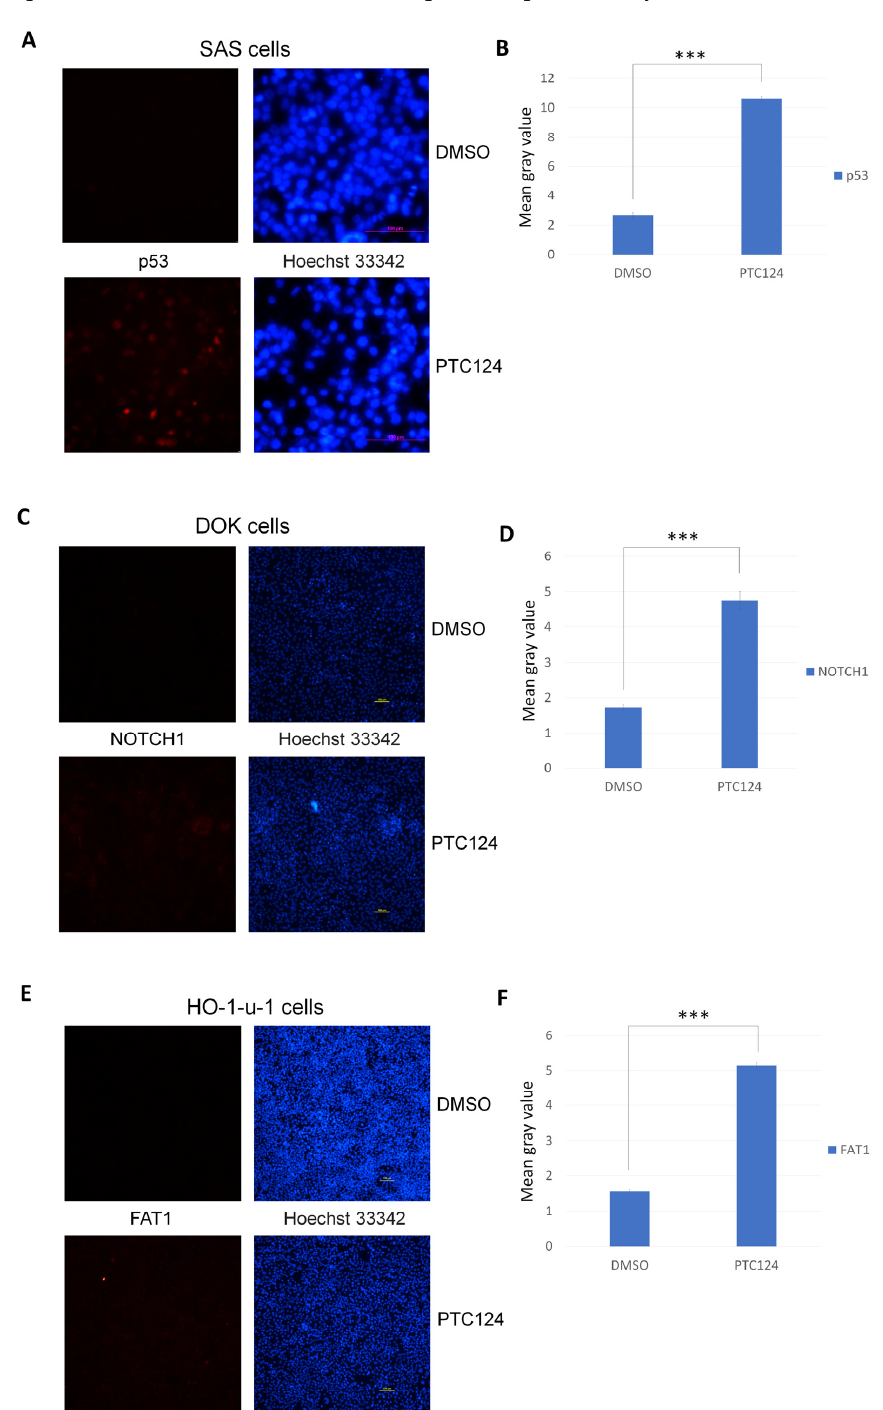
Figure 2. PTC124 can induce NOTCH1 and FAT1 expression in DOK and HO-1-u-1 cells, respectively. ( A ) PTC124 (50 µ M) can induce p53 in SAS cells. ( B ) p53 fluorescence intensity is dramatically inducted by PTC124 (*** p < 0.001). Results are displayed as mean ± SD, n = 3. ( C ) PTC124 (50 µ M) can induce NOTCH1 in DOK cells. ( D ) NOTCH1 fluorescence intensity is dramatically induced by PTC124 (*** p < 0.001). Results are displayed as mean ± SD, n = 3. ( E ) PTC124 (50 µ M) can induce FAT1 in HO-1-u-1 cells. ( F ) FAT1 fluorescence intensity is dramatically induced by PTC124 (*** p < 0.001). Results are displayed as mean ± SD, n =